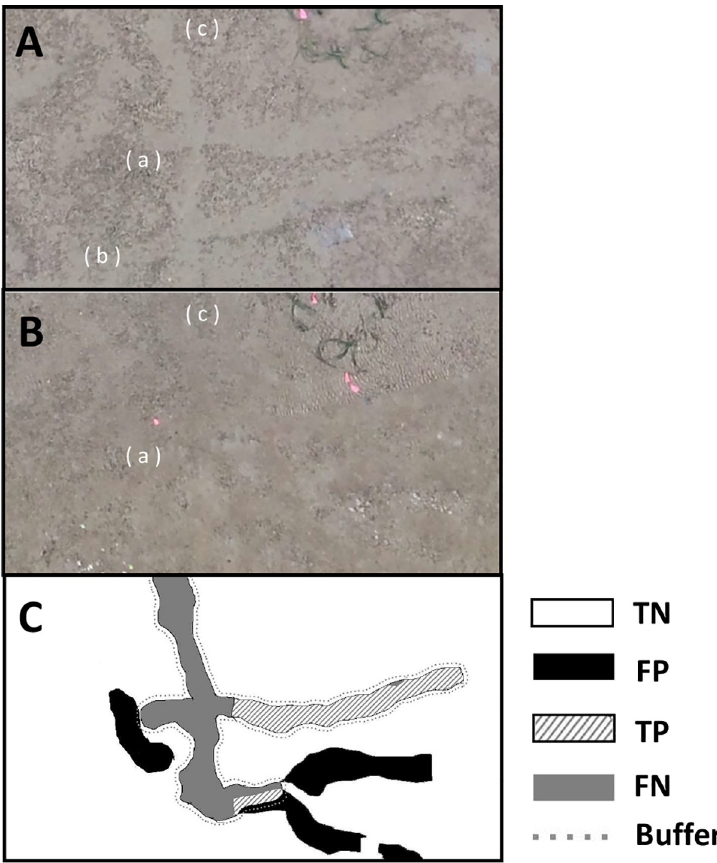
Fig 13. Examples of the extraction errors; (A) orthophoto of a certain day and (B) orthophoto of 10 days later, (C) extraction of (B). True negatives TN are in white, false positives FP in black, true positives TP in the striped area, and false negatives FN in the gray area. The gray dotted line shows the buffer boundaries of the 7 pixels (0.47 cm/pix) used in this study.